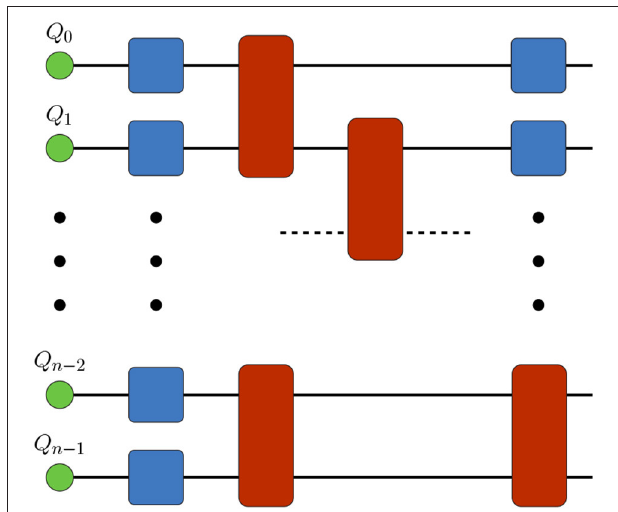
FIGURE 4 | Quantum circuit simulation by direct contraction of the circuit tensor network with ExaTN. Qubits are represented as order-1 tensors. Tensors describing quantum gates are appended to the qubit register according to the quantum circuit specification. Full contraction of the tensor network produces the complete wave-function.